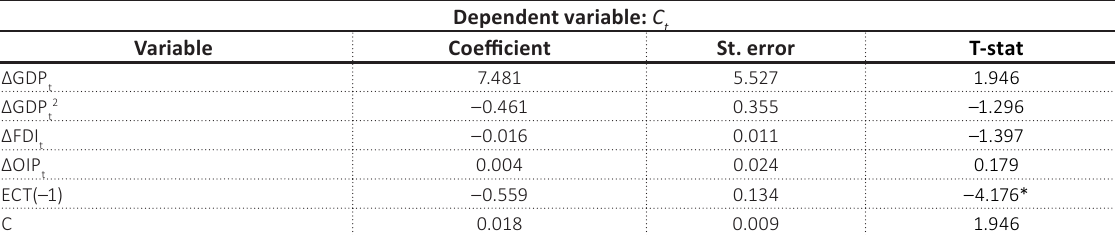
Table 4. Linear ARDL model short-run results